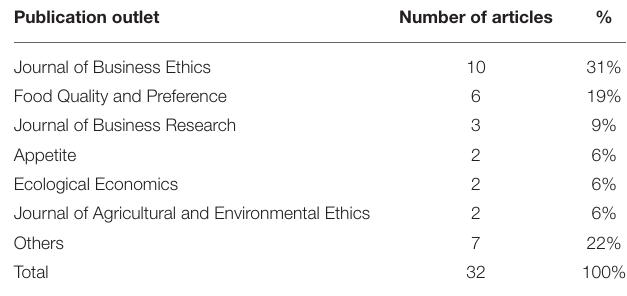
TABLE 2 | Number of articles per research methodology. TABLE 3 | Number of articles per